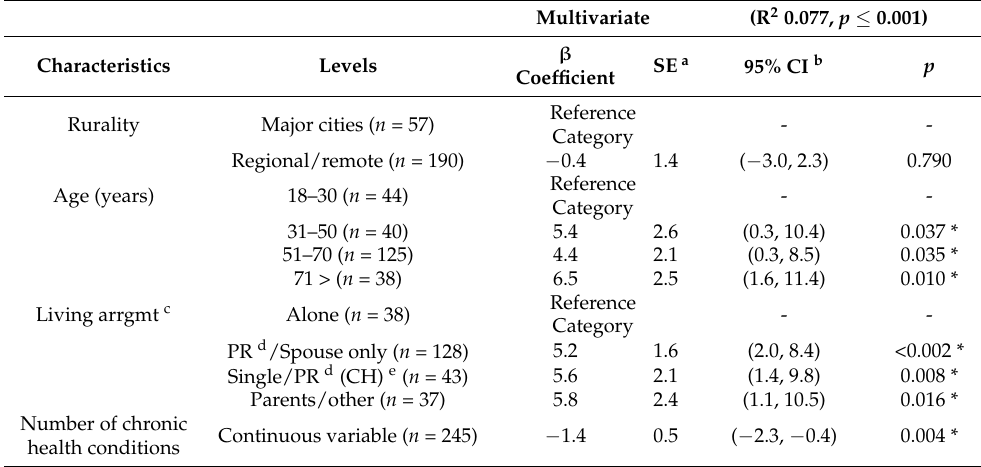
Table 4. Multivariate linear regression demonstrating the association between socio demographic variables and total